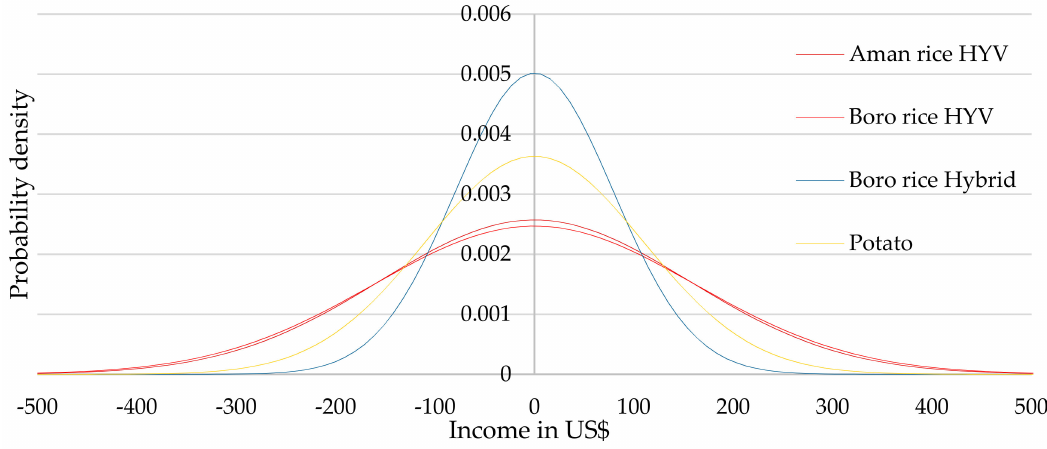
Figure 9. Distribution of agricultural income (US$) for farm households in Rangpur by crop